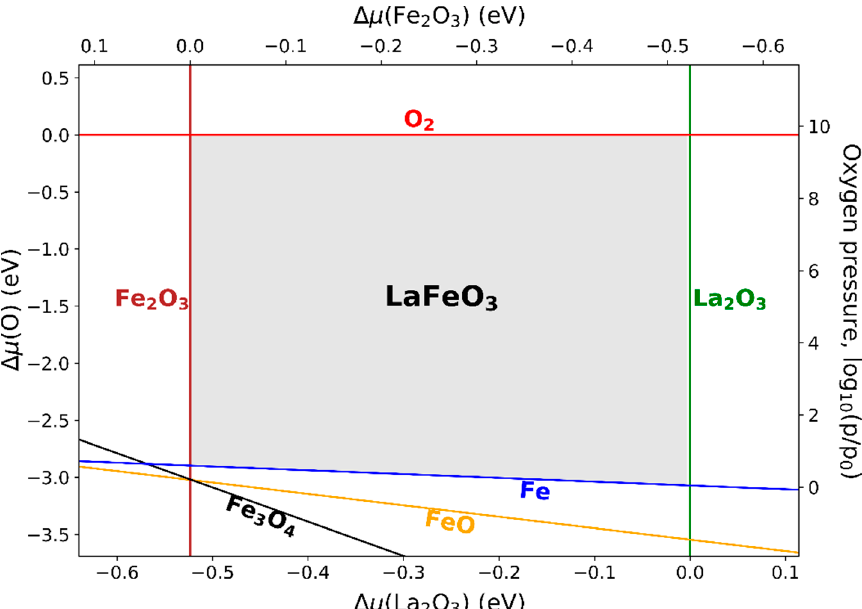
Figure 4. Phase diagram of LaFeO 3 with respect to the chemical potentials of the oxide components La 2 O 3 (Fe 2 O 3 ) and oxygen. At a given temperature, which was chosen as 1400 K, in this case, ∆ µ O can be expressed by the pressure of the oxygen gas (right vertical axis, logarithmic scaling in units of p 0 = 1 atm). The lines mark the transitions to the denoted competing